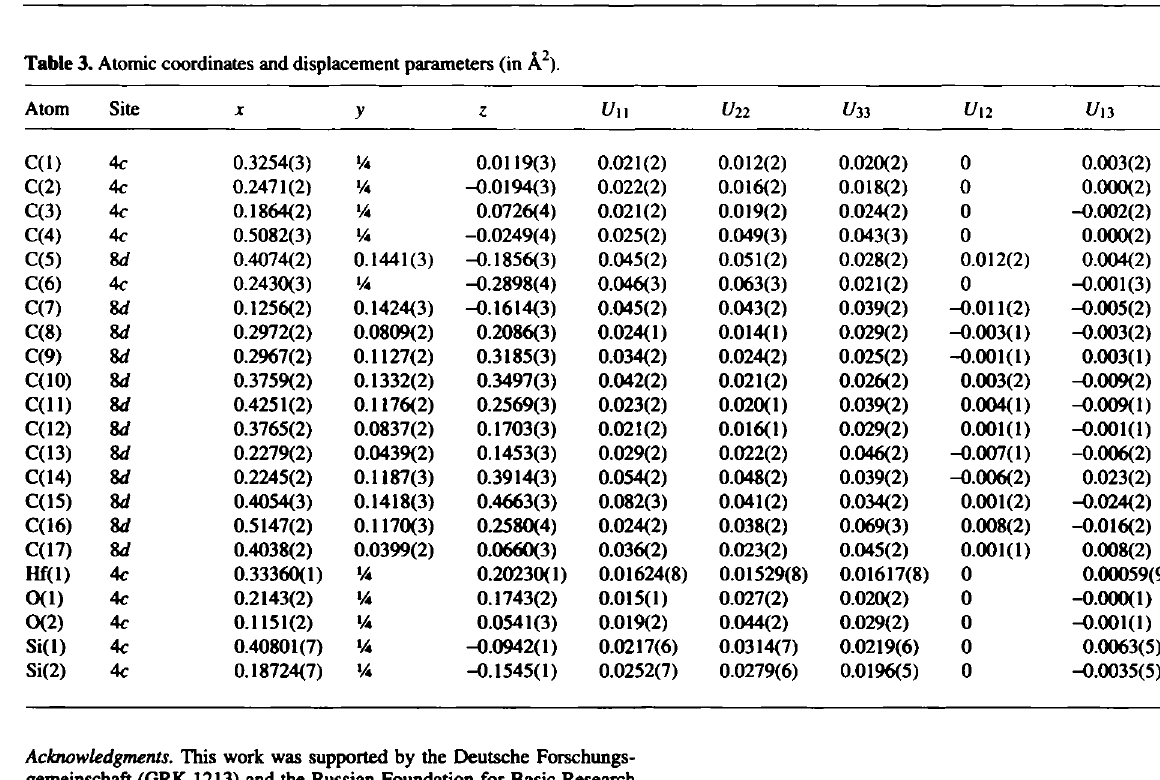
Table 3. Atomic coordinates and displacement parameters (in Â 2